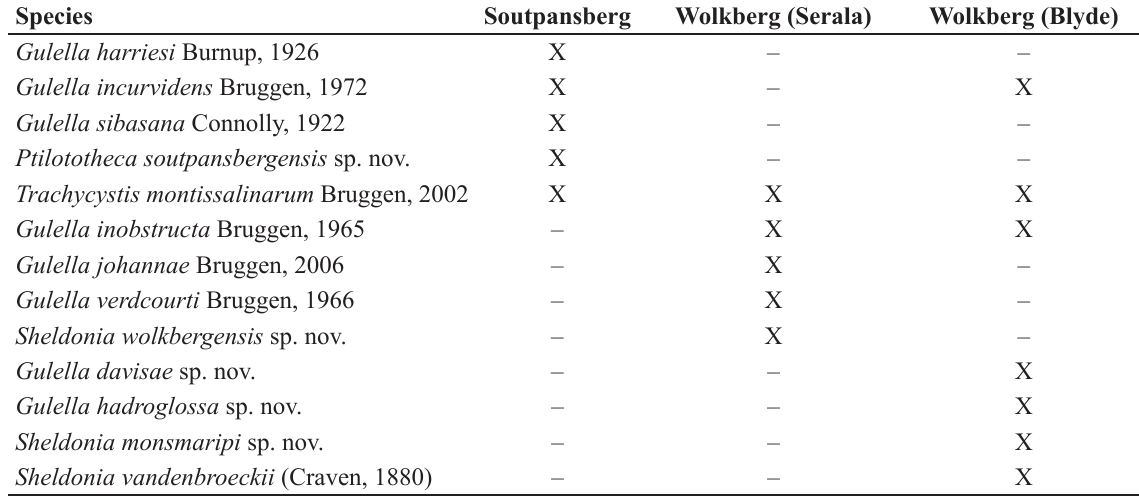
Table 1. Land snail species endemic to the Soutpansberg and/or Wolkberg centres of